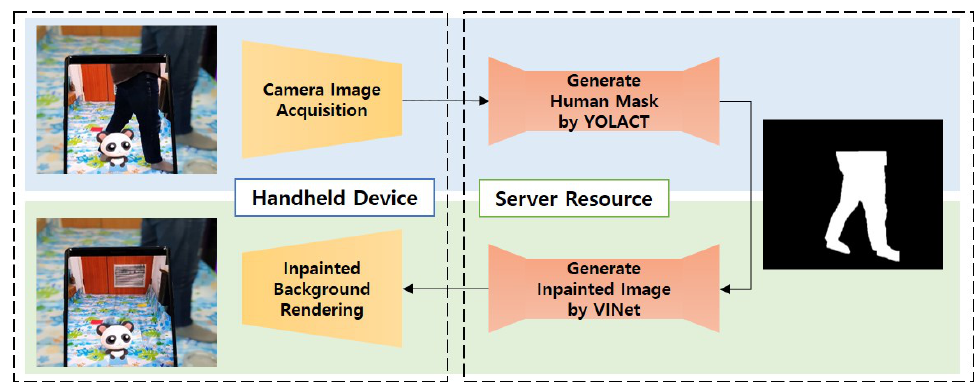
Figure 4. The system architecture of the content-irrelevant real object (CIRO) diminishing algorithm. The video frames from the mobile AR client are passed to the server for segmentation of the human body (i.e., CIRO) and the creation of the CIRO mask, and then passed back to the AR client for inpainting of it.